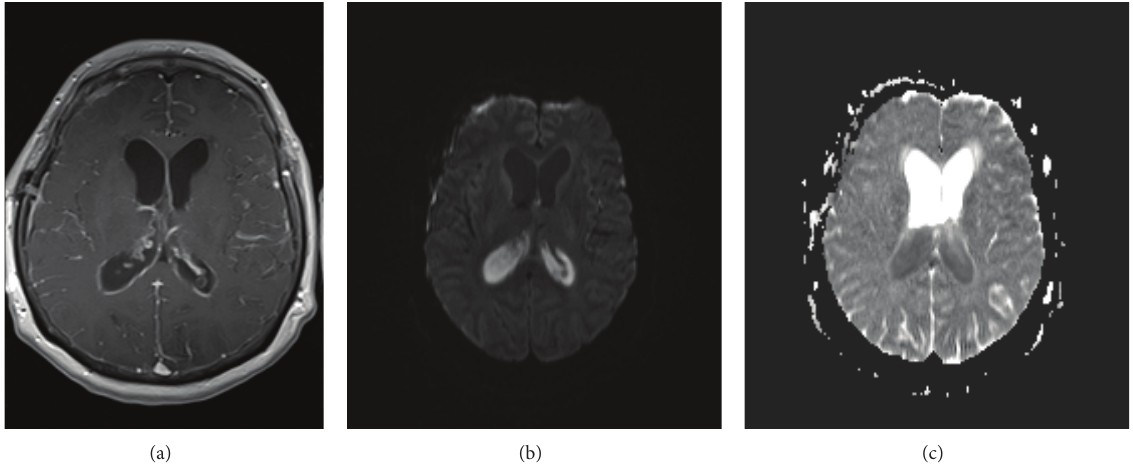
Figure 2: MRI brain. MRI: magnetic resonance imaging. (a) Axial T1 with gadolinium displaying ependymal enhancement in the lateral ventricles. (b) Axial diffusion weighted imaging displaying intraventricular hyperintensity, concerning restriction of ventricular sediment and consistent with ventriculitis/empyema. (c) Apparent diffusion coefficient map confirming intraventricular hypointensity and restricted diffusion of the intraventricular sediment, confirming